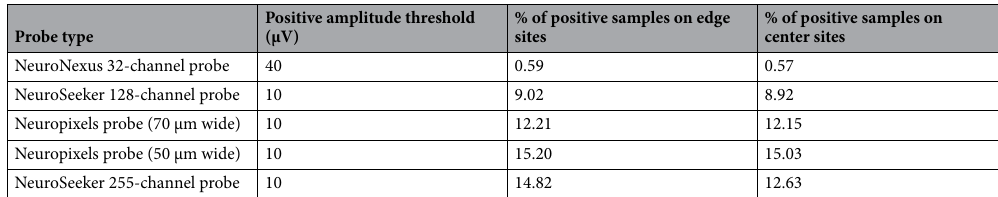
Table 5. Minimal positive amplitude thresholds above which significantly more edge samples were